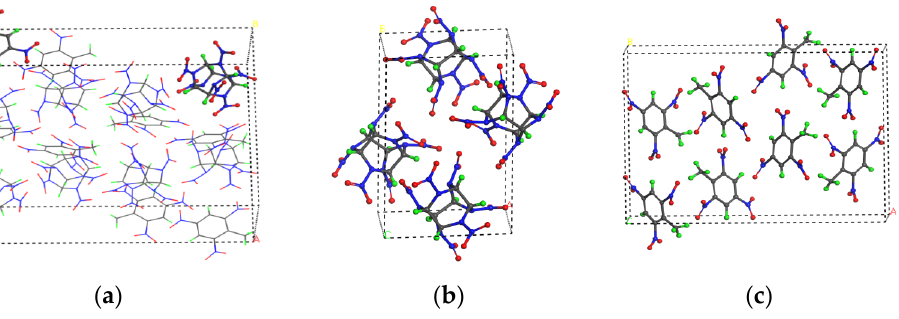
Figure 1. Unit-cell structures of the ( a ) CL-20/TNT, ( b ) CL-20 and ( c ) TNT crystals. (C, H, O and N atoms are shown in grey, green, red and blue, respectively.)